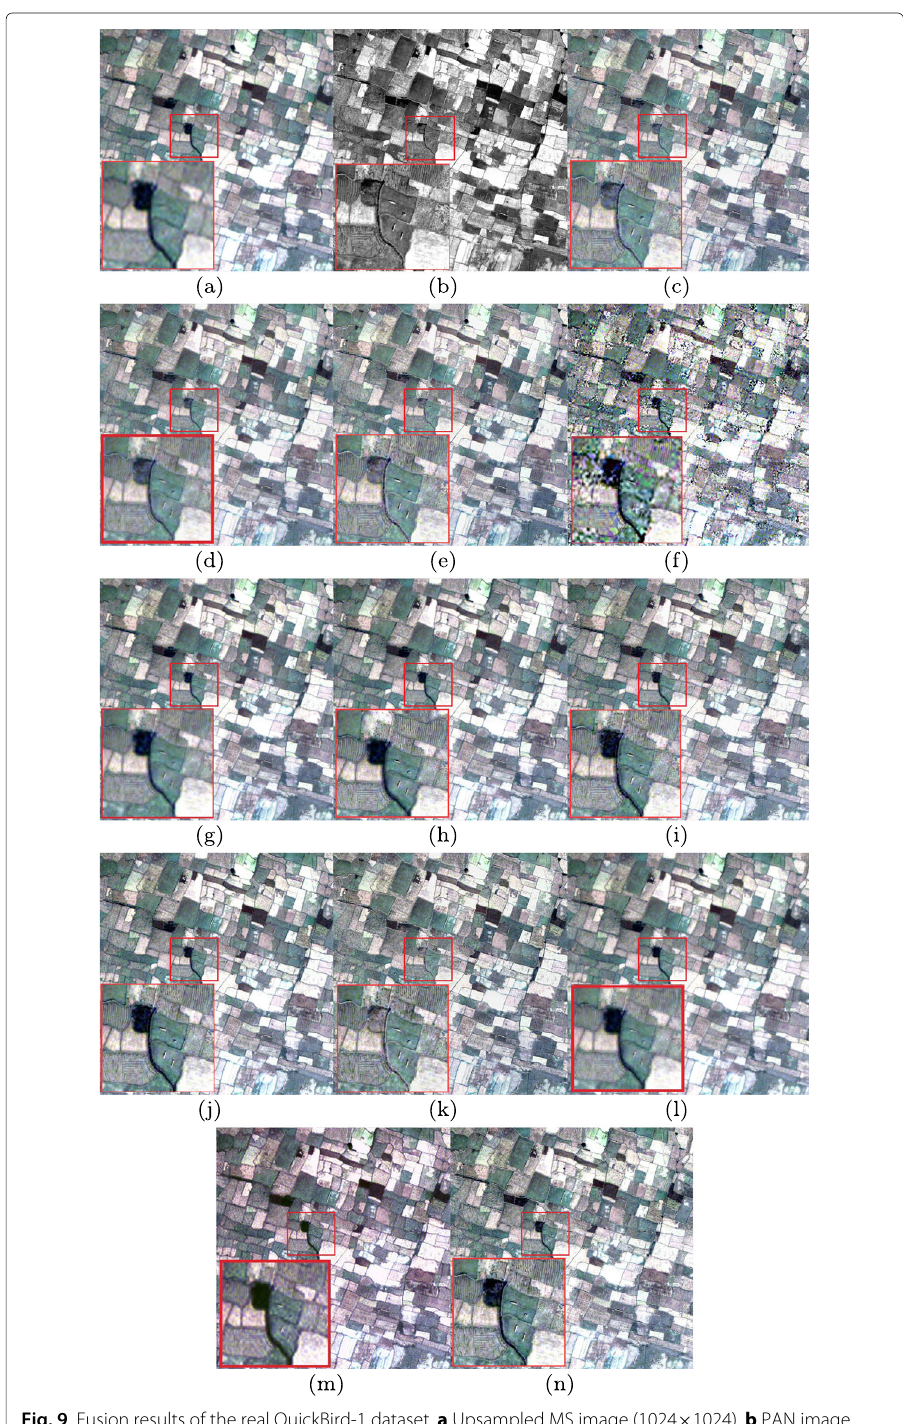
Fig. 9 Fusion results of the real QuickBird-1 dataset. a Upsampled MS image (1024 × 1024). b PAN image (1024 × 1024). c IHS method. d AIHS method. e PCA method. f BDSD method. g PRACS method. h